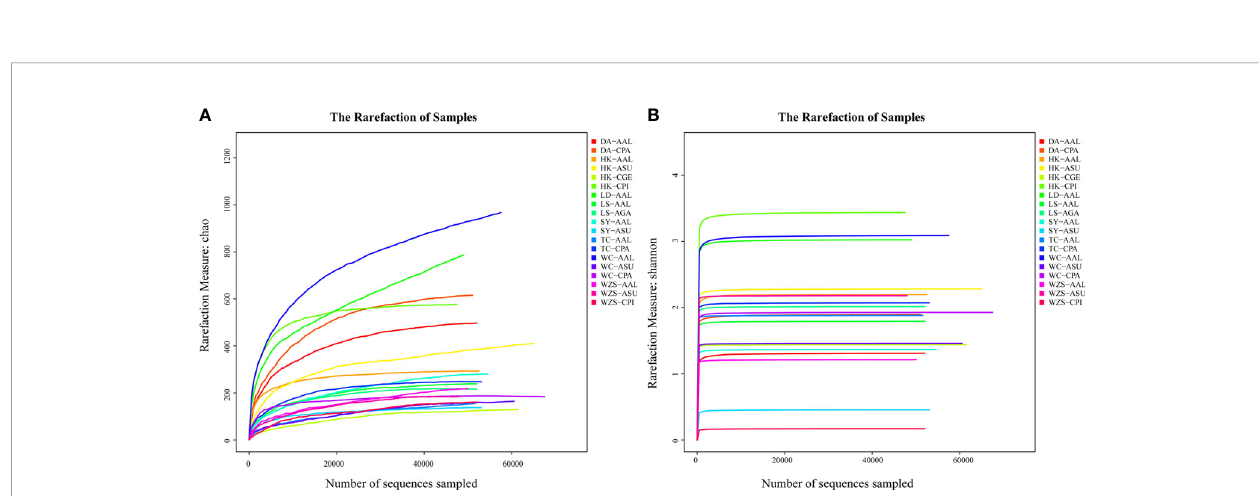
FIGURE 4 | Rarefaction analysis of observed richness Chao (A) and Shannon index (B) within individual